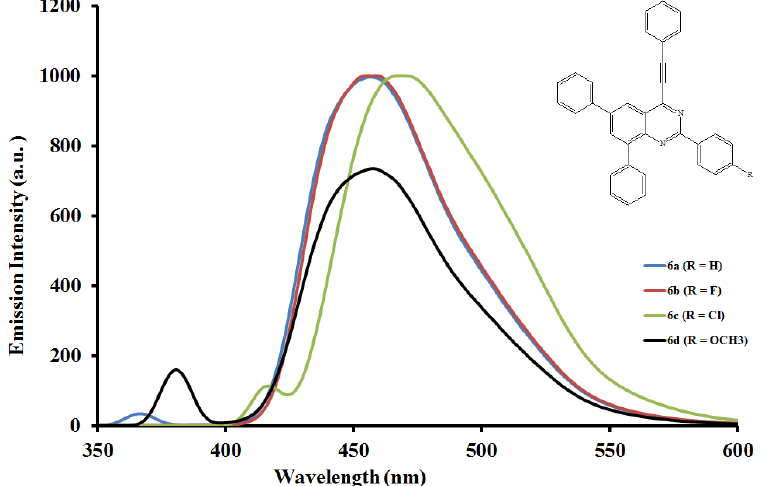
Figure 7. The emission spectra of compounds 6a – d ( λ ex = 400 nm) in DMF (0.022 mmol/L) at rt.